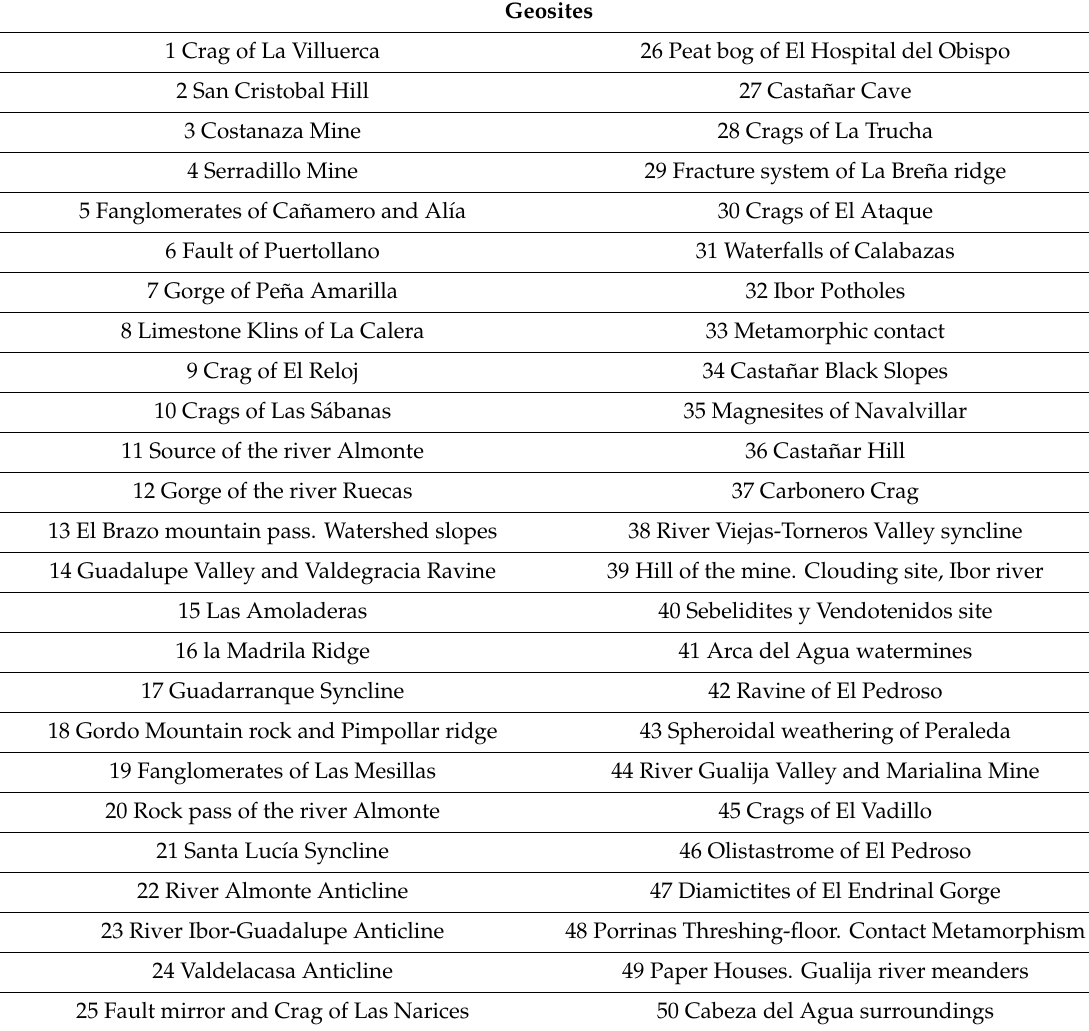
Table 1. Geoparks´Geosites (Figure 1). Source: UNESCO Global Geopark Villuercas-Ibores-Jara [56].